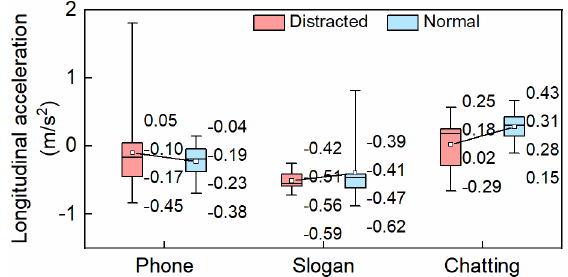
Figure 9. Longitudinal acceleration.